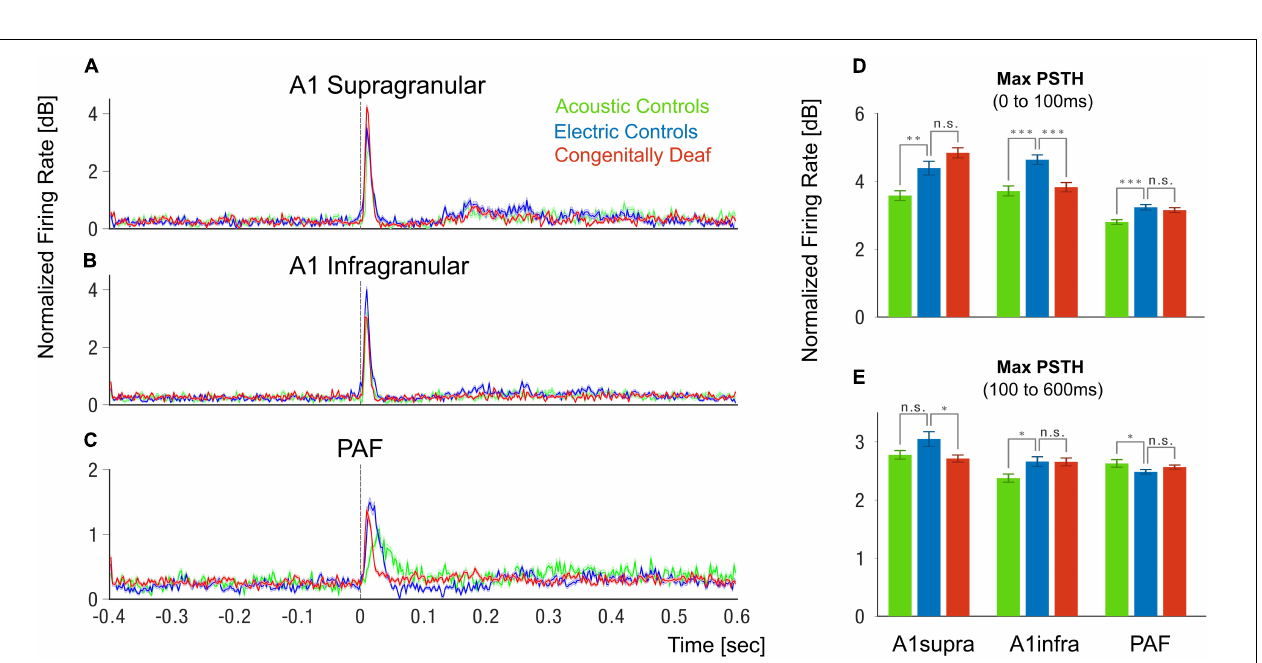
FIGURE 3 | Peristimulus histogram grand mean. (A–C) Grand mean of the peristimulus histograms (PSTHs) in supragranular layers of A1 (A) , infragranular layers of A1 (B) , and posterior auditory field (C) . PSTHs are plotted in normalized firing rate (dB relative to mean- prestimulus). Shaded areas show the standard error of the mean. (D–E) Bar plots of PSTH maximum for the three groups and three different areas and layers for the early time window (0–100 ms), (D) and late time window (100–600 ms), (E) . Green represents Acoustic Controls, blue represents Electric Controls, and red represents Congenitally Deaf Cats. N.s. not significant, ∗ p < 0.05, ∗∗ p < 0.01, ∗∗∗ p < 0.001, t -test